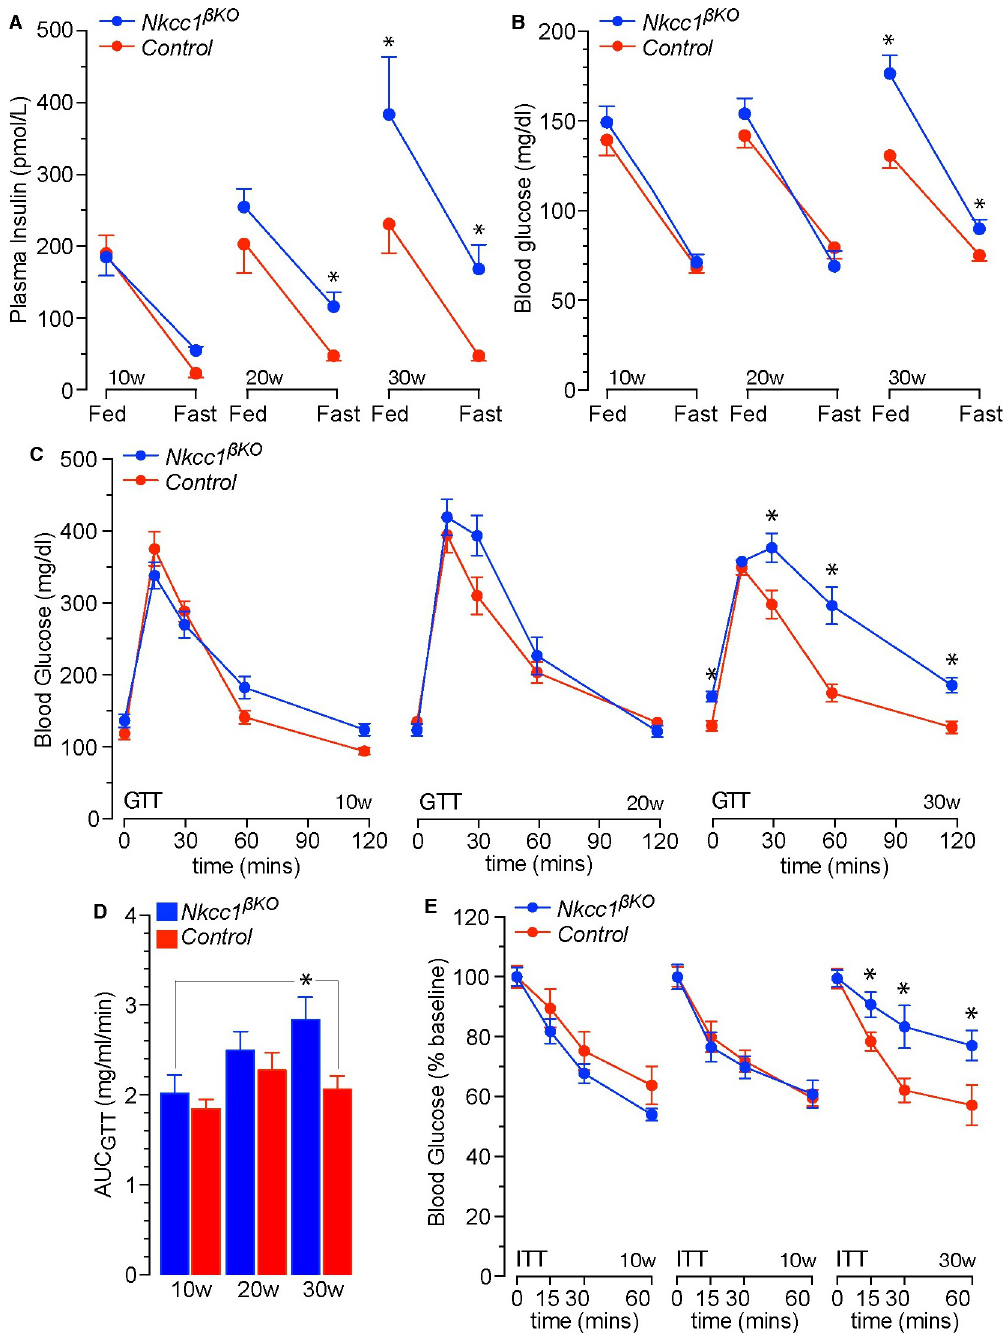
Fig 6. Plasma insulin, blood glucose, glucose tolerance and insulin sensitivity of Nkcc1 β KO mice. A, B . Plasma insulin (A, pmol/L) and whole blood glucose (B, mg/dl) of 10w, 20w and 30w old Nkcc1 β KO and control ( Ins1 Cre ) mice fed or fasted 16h. Results represent the mean ± SEM ( n = 17–28, � p < 0.05). C, D . Blood glucose excursions (mg/dl) during glucose tolerance tests (GTT, C) performed in 6h fasted Nkcc1 β KO and control ( Ins1 Cre ) mice of the indicated ages (mean ± SEM, n = 9–14, � p < 0.05) and the areas under the curve (D, mg/ml/min) of those responses. E . Blood glucose responses to exogenous insulin during insulin tolerance tests (ITT) performed in 6h fasted Nkcc1 β KO and control ( Ins1 Cre ) mice at 10w, 20w and 30w of age. Each point represents the mean ± SEM ( n = 9–16, � p <